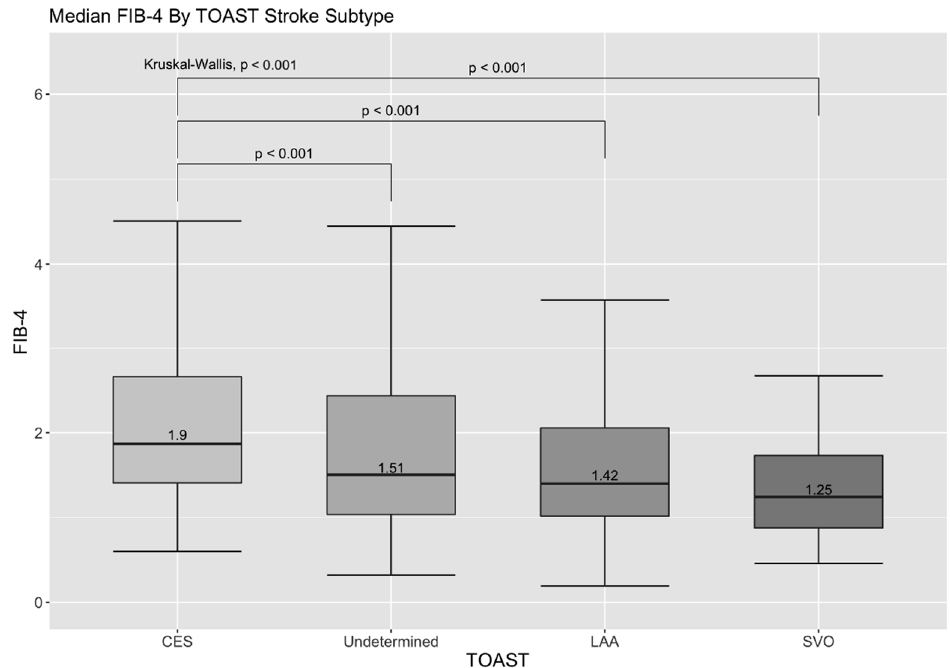
Figure 1. This is a boxplot depicting the median FIB-4 across the four different stroke mechanisms according to the TOAST classification, namely Cardioembolic stroke, Stroke of Undetermined Etiology, Large Artery Atherosclerosis and Small Vessel Occlusion. Error bars represent the 25th and 75th quartile of FIB-4 for each TOAST mechanism. Mann–Whitney U test determined that there was a significant difference between FIB-4 between Cardioembolic stroke and each of the four TOAST stroke subtypes groups at p < 0.001. The Kruskal–Wallis test, which determined if there was overall a statistically significant difference between any one of the four groups, was also statistically significant at p < 0.001.